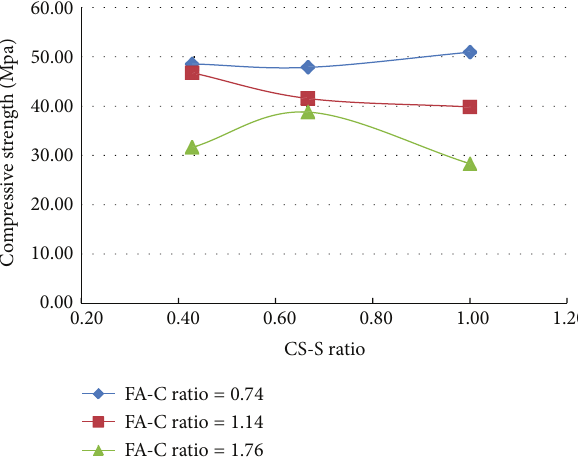
Figure 4: Compressive strength versus CS-S ratio (specimens S10– S18: with steel fibres).